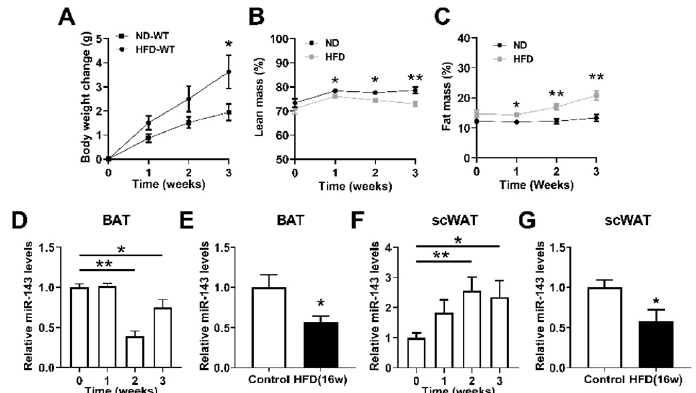
Figure 1. miR-143 is downregulated in BAT of mice induced by HFD. ( A ) The body weight of mice fed HFD or ND (n = 8). ( B , C ) The fat and lean mass of mice fed ND or HFD (n = 8). ( D , F ) The miR-143 expression in BAT ( D ) and scWAT ( F ) of mice fed HFD for indicated times lengths (n = 8). ( E , G ) The miR-143 expression in BAT ( E ) and scWAT ( G ) of mice fed HFD for 16 weeks (n = 8). Data are presented as the mean ± SEM. * p < 0.05 vs. controls; ** p < 0.01 vs. controls, as determined by a two-tailed unpaired Student’s t